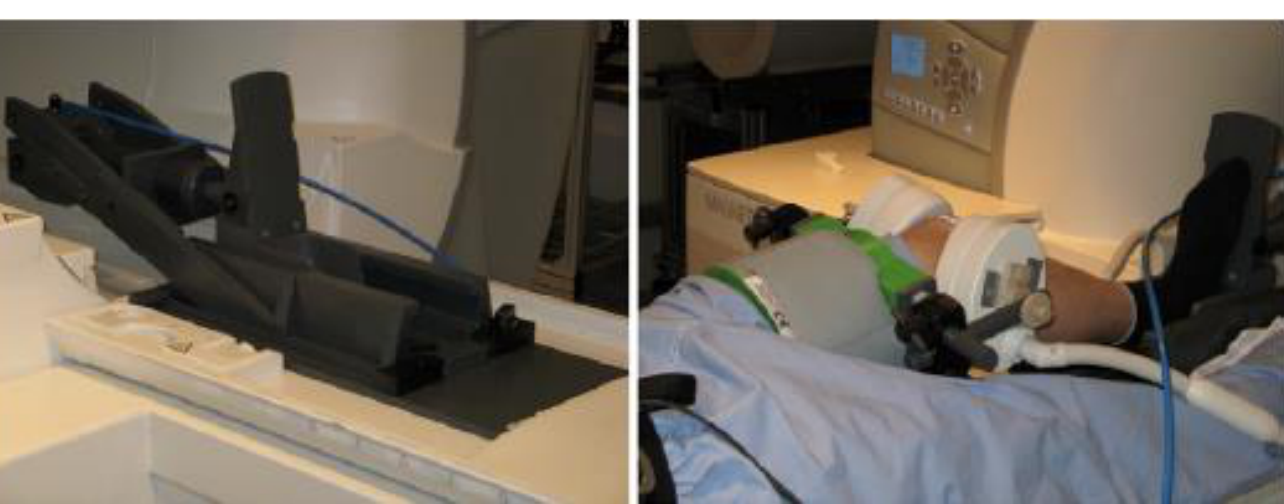
Figure 2. Experimental Setup. The knee is loaded with an MR-compatible pneumatic loading device (left). The multipurpose coil is attached to the thigh and the tracking marker for prospective motion correction is taped to the knee cap (right).